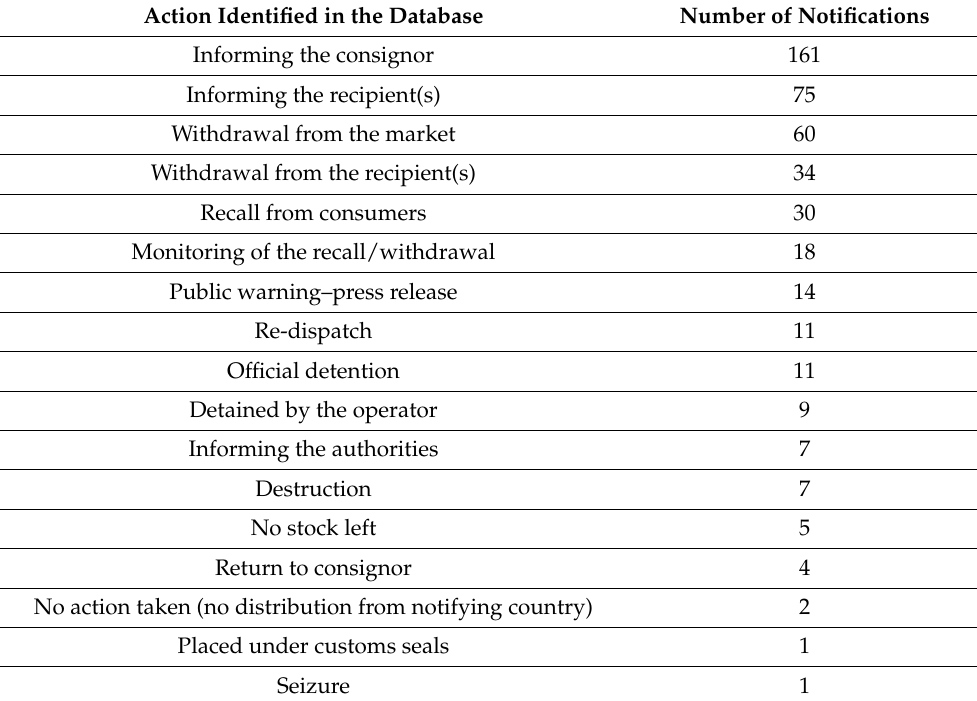
Table 4. Actions identified in the RASFF database following notifications linked to ethylene oxide contamination in sesame food products from India being issued over the period 1 September 2020–31 August 2021 (Source: Own elaboration based on